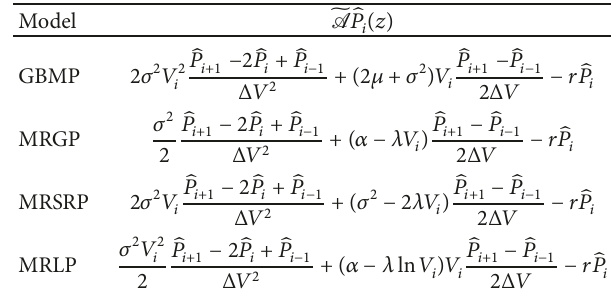
Table 3: Difference